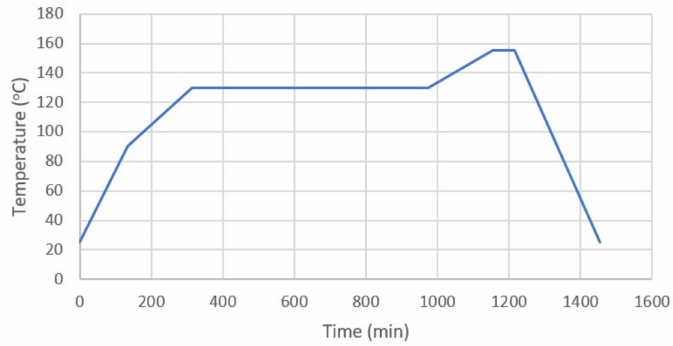
Figure 7. Heating protocol used for the synthesis of the membranes.